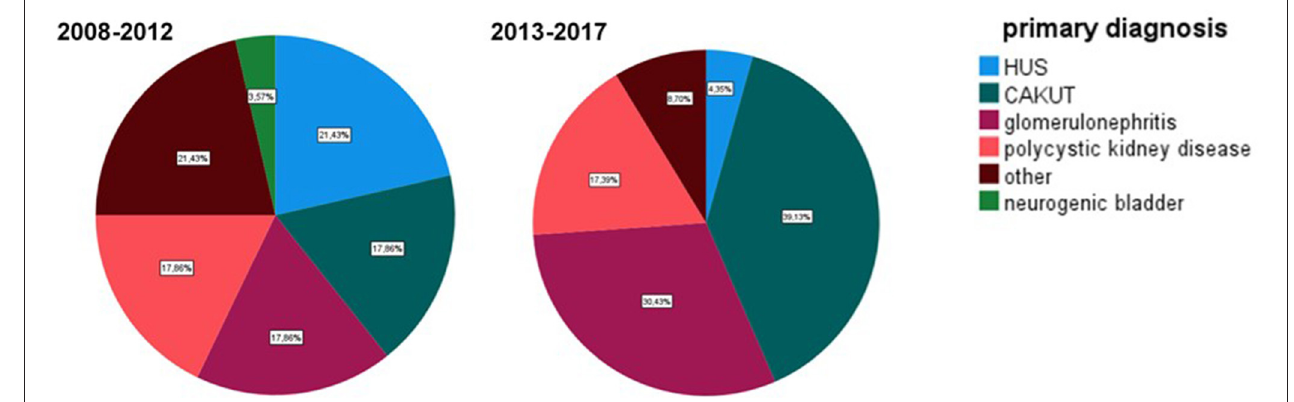
FIGURE 1 | Primary diagnosis in the analyzed eras. Era 1 2008–2012, era 2 2013–2017.